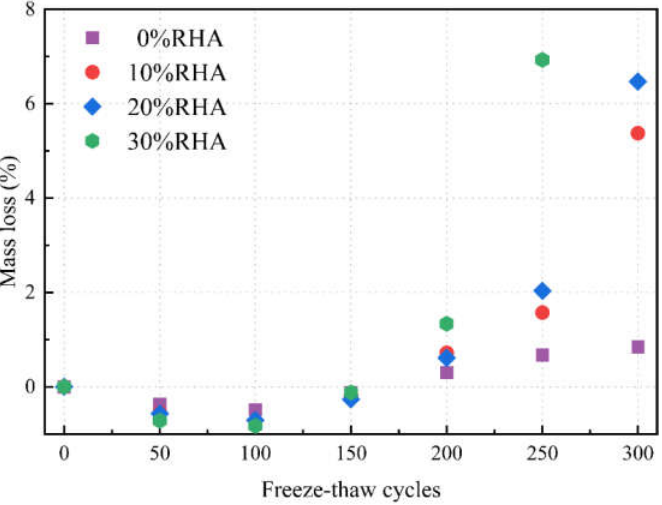
Figure 6. The relationship between the mass loss of recycled concrete and the number of freeze– thaw cycles with different RHA replacement ratios. cycles with different RHA replacement